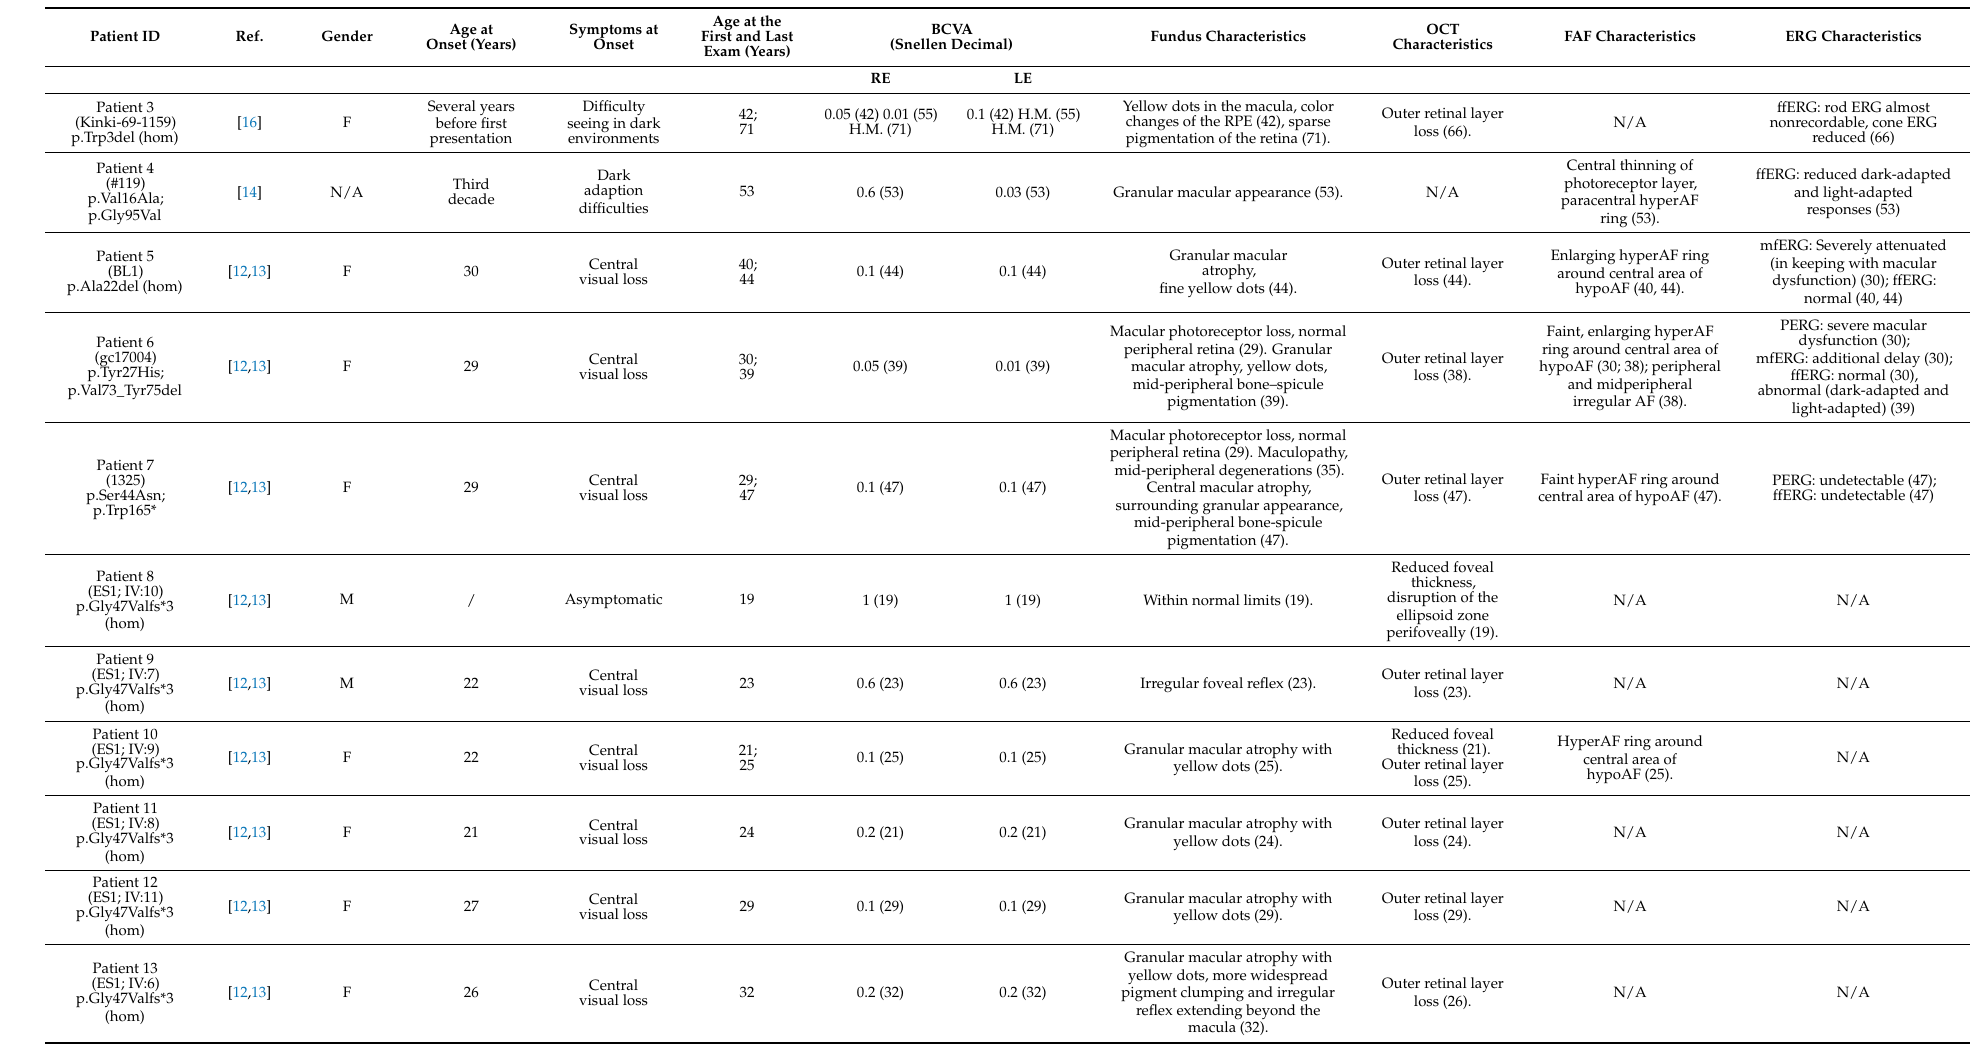
Table 3. The clinical characteristics of previously published cases with variant in DRAM2 .